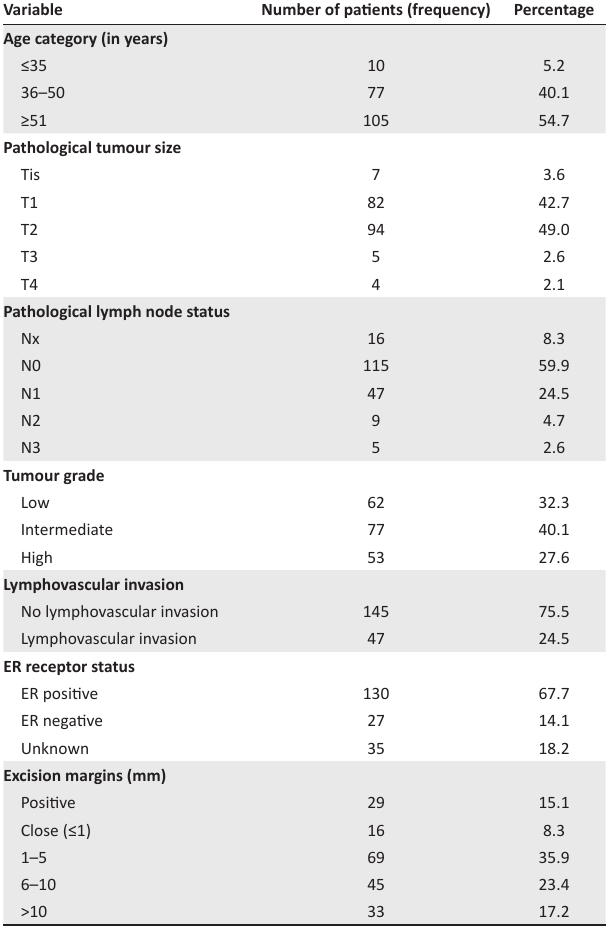
TABLE 1: Patient and tumour characteristics.